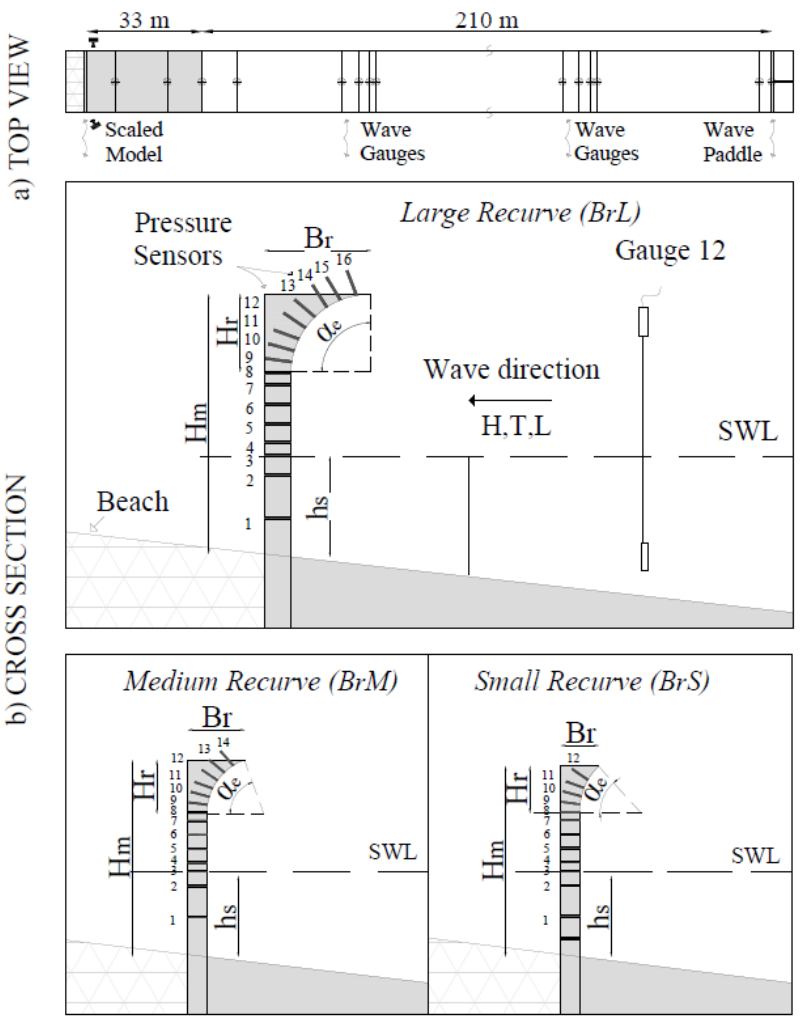
Figure 3. Experimental setup and instrumentation of the seawall and the recurves; ( a ) top view and ( b ) cross section.